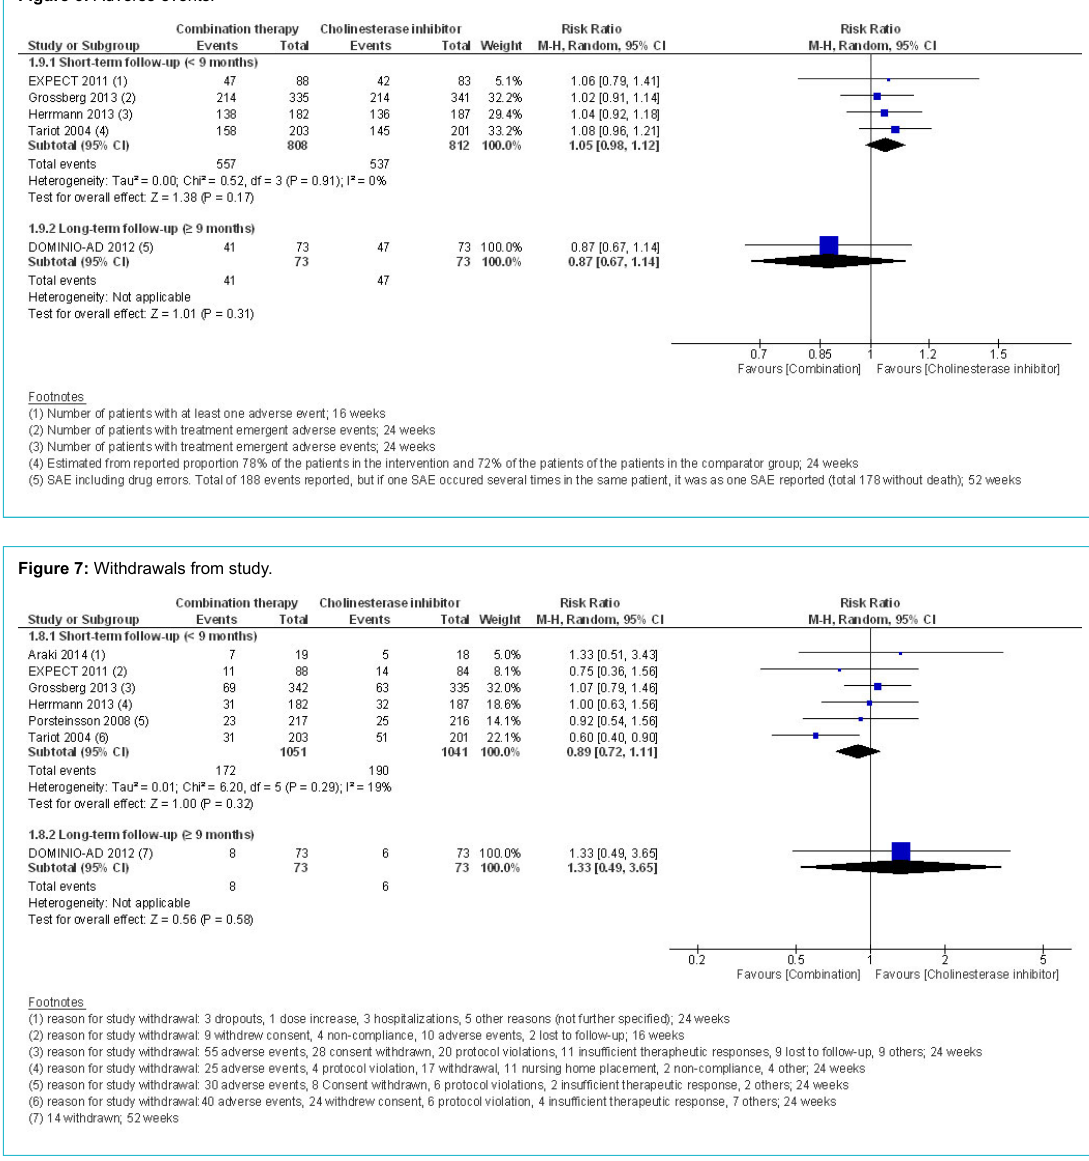
Figure 6: Adverse events.